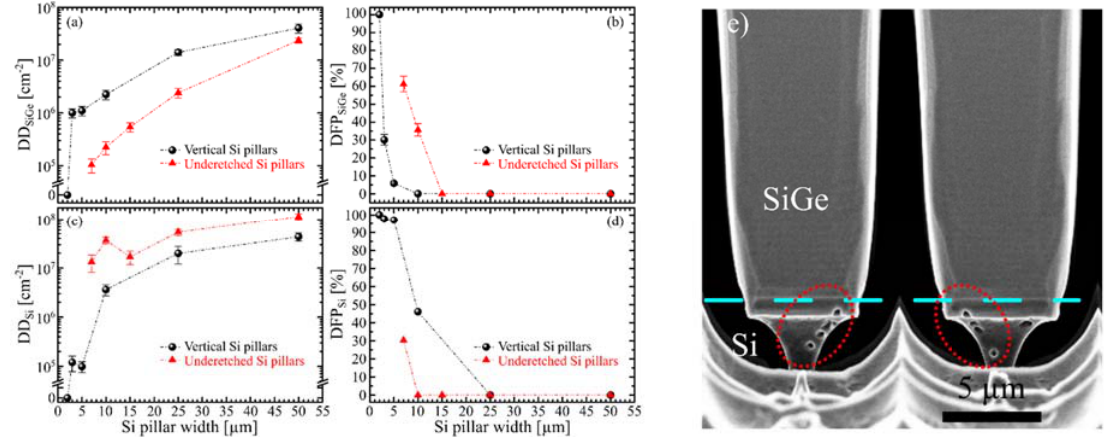
Figure 11. Experimental characterization of dislocations in SiGe crystals. ( a ) Average dislocation density in SiGe crystals (DDSiGe) deposited on vertical (black spheres) and under-etched (red triangles) Si pillars with different widths. ( b ) Probability of having dislocation-free SiGe crystals (DFPSiGe) as a function of the vertical (black spheres) and under-etched (red triangles) Si pillars width. ( c , d ) Analogous to ( a , b ), respectively, but for dislocations located in the Si pillars. The strong tendency towards dislocations piling-up in the Si region is well evident in the SEM image reported in panel ( e ). Reproduced with permission from [46]. American Physical Society.